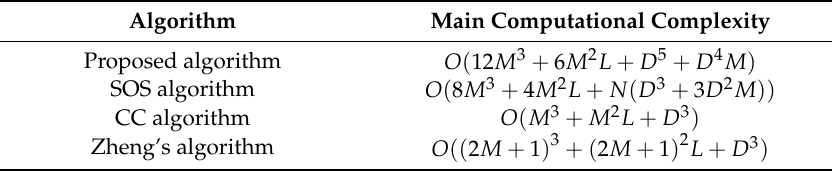
Table 1. Comparison of different algorithms in computational